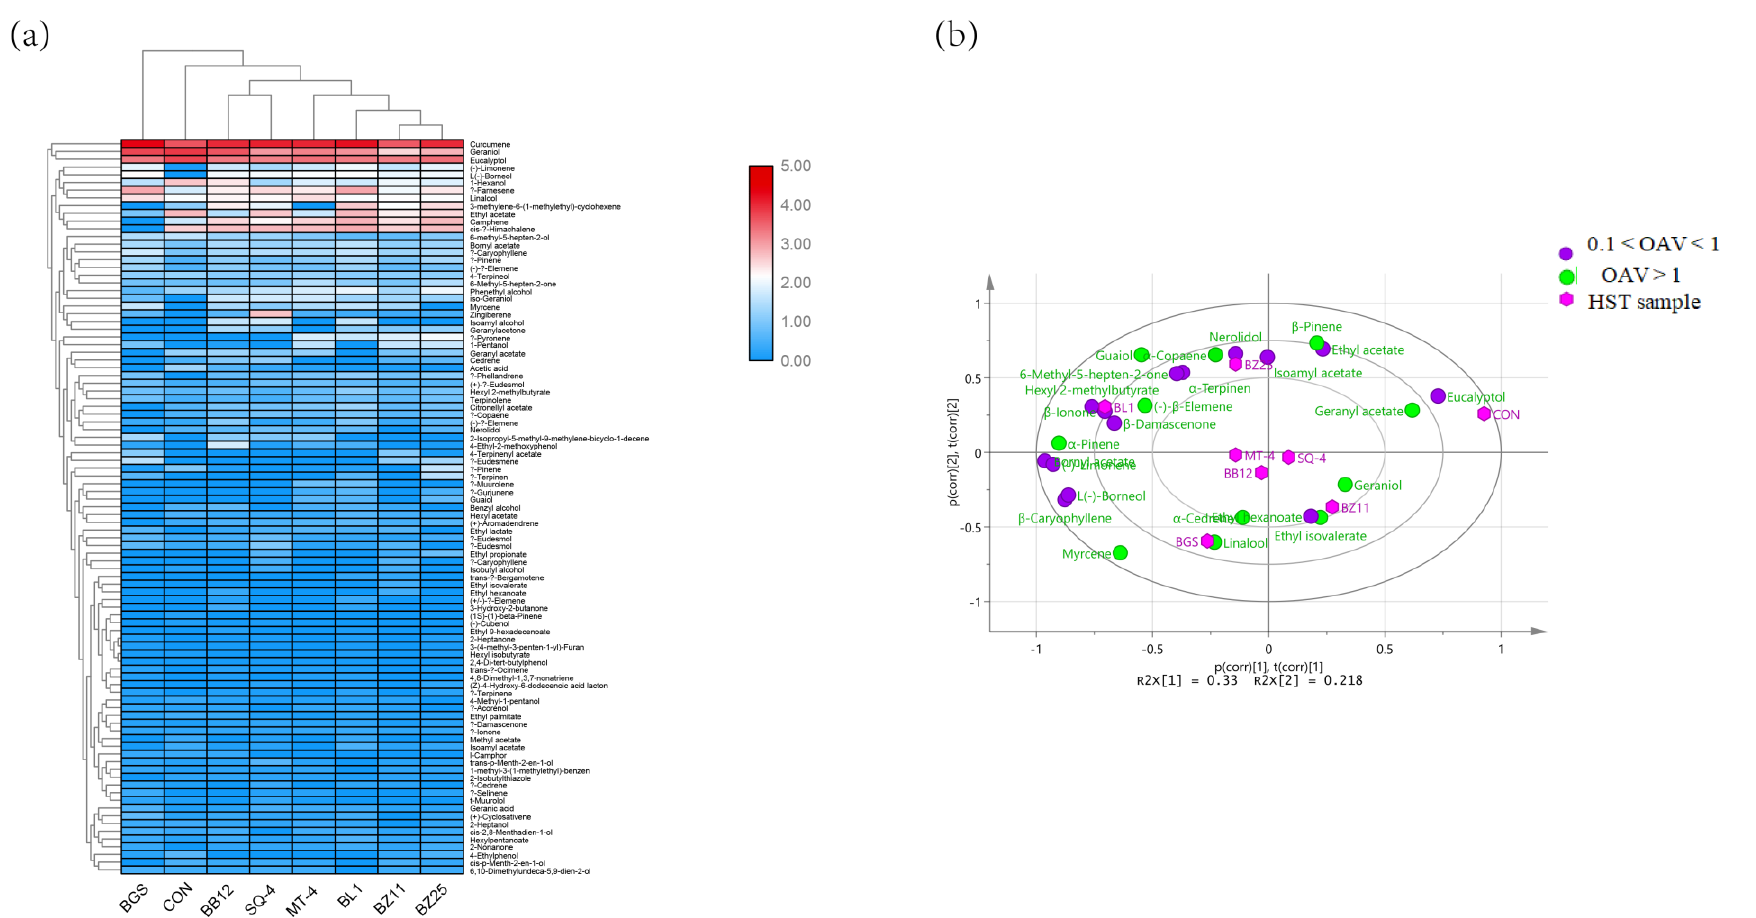
Figure 2. Heat map visualization and clustering results of the volatile compounds in HST ( a ) and biplot of principal component analysis from aroma compounds (OAV > 0.1) ( b ).